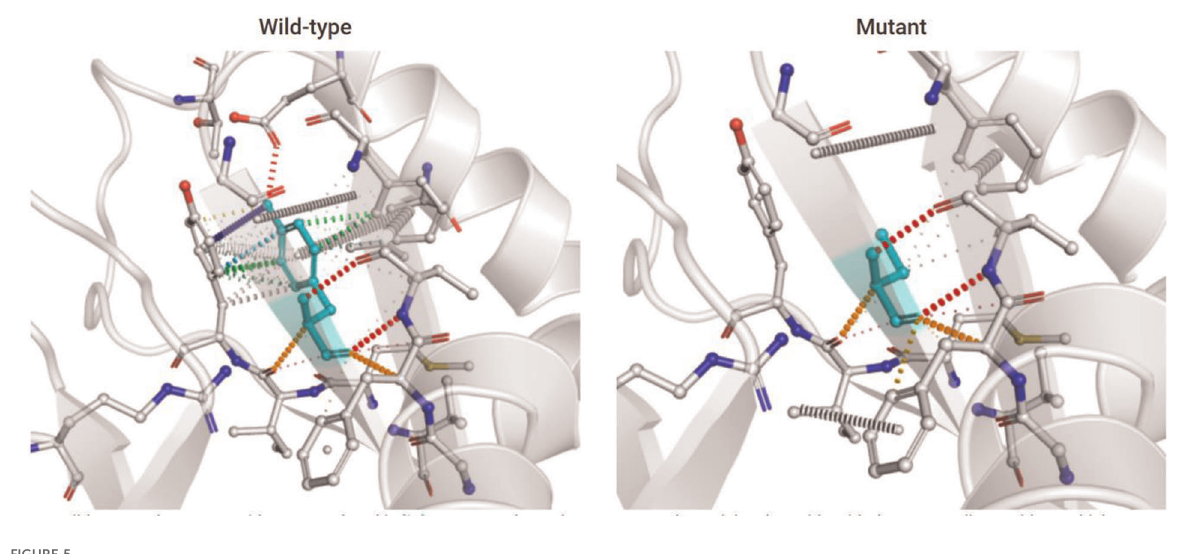
FIGURE 5 Prediction of interactomic interactions of the wild-type and mutant site (Y106 residue mapped to Y94 in the PDB structure). Residues in the wild-type and mutant sites were colored in light green and shown as sticks. The respective chemical interactions were labeled as dotted lines and colored as follows: hydrogen bonds — (red), weak hydrogen bonds — (orange), hydrophobic contacts — (green), amide-amide contacts — (blue), and ionic interactions — (gold). Amino acid residues were also colored according to type, namely nitrogen (blue), oxygen (red), and sulfur (yellow). In comparison to the wild-type site, some interactions (hydrophobic contacts, amide-amide contact, and ionic interactions) were observed to be lost in the mutant